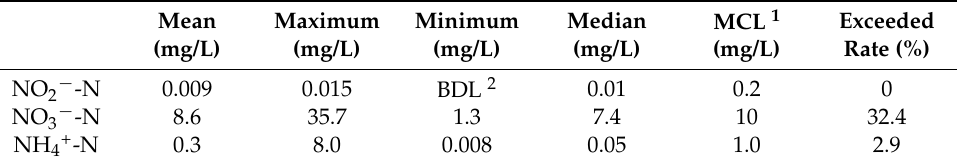
Table 1. Statistics of three different forms of nitrogen of all the water